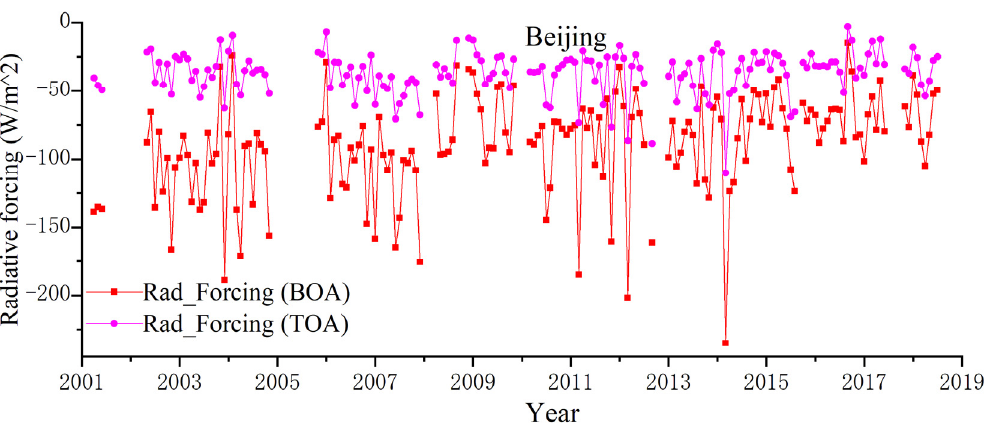
Figure 12. Temporal variations of monthly aerosol radiative forcing in Beijing.